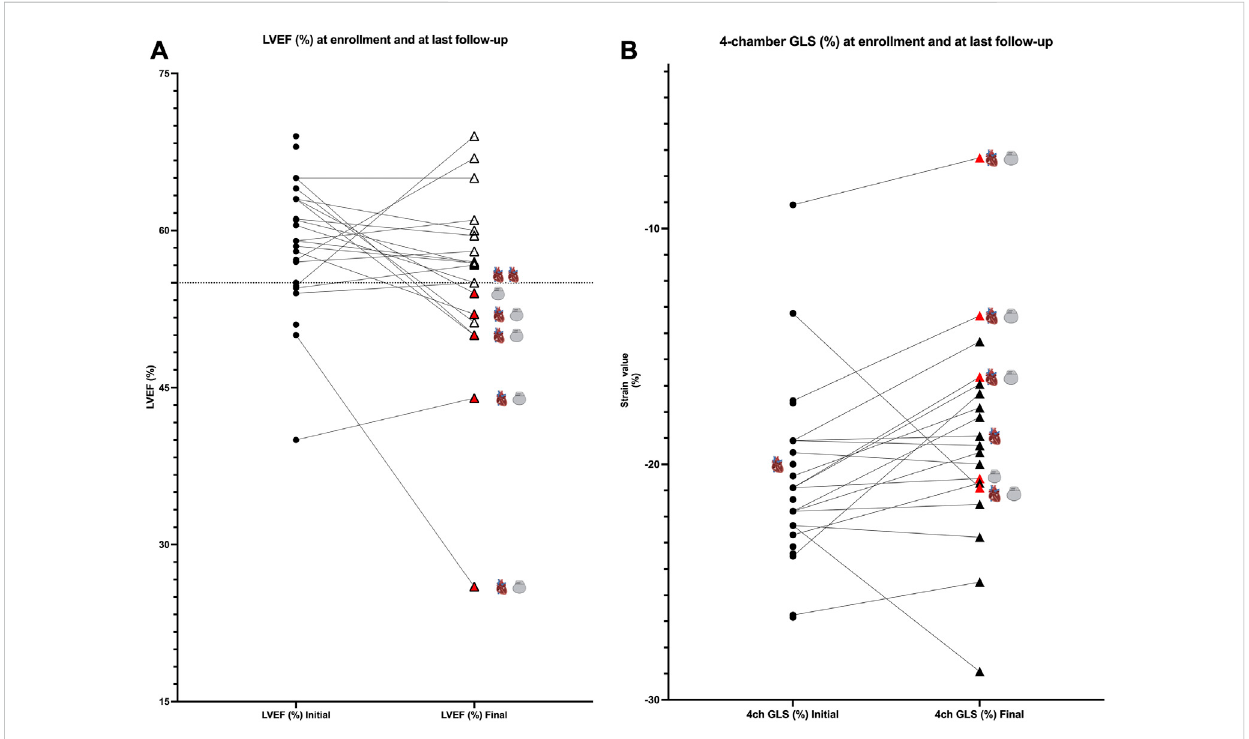
FIGURE 2 (A) : comparison of values at enrollment and at last follow-up; LVEF values (%). Patients are represented as black dots at enrollment, and triangles representpatientsatlastfollow-up.RedtrianglesshowpatientsrequiringanICD(graydevicerepresentedinthegraphic).Cardiomyopathyisrepresented byaheart.Blacklineslinkthesamepatientinthetwodifferentmomentsoffollow-up. (B) :comparisonofvaluesatenrollmentandatlastfollow-up;four- chamberGLSvalues(%).Patientsarerepresentedasblackdotsatenrollmentandtrianglesatlastfollow-up.Redtrianglesshowpatientsrequiringan ICD (gray device represented in the graphic). Cardiomyopathy is represented by aheart. Black lines link the same patient in the two different moments of